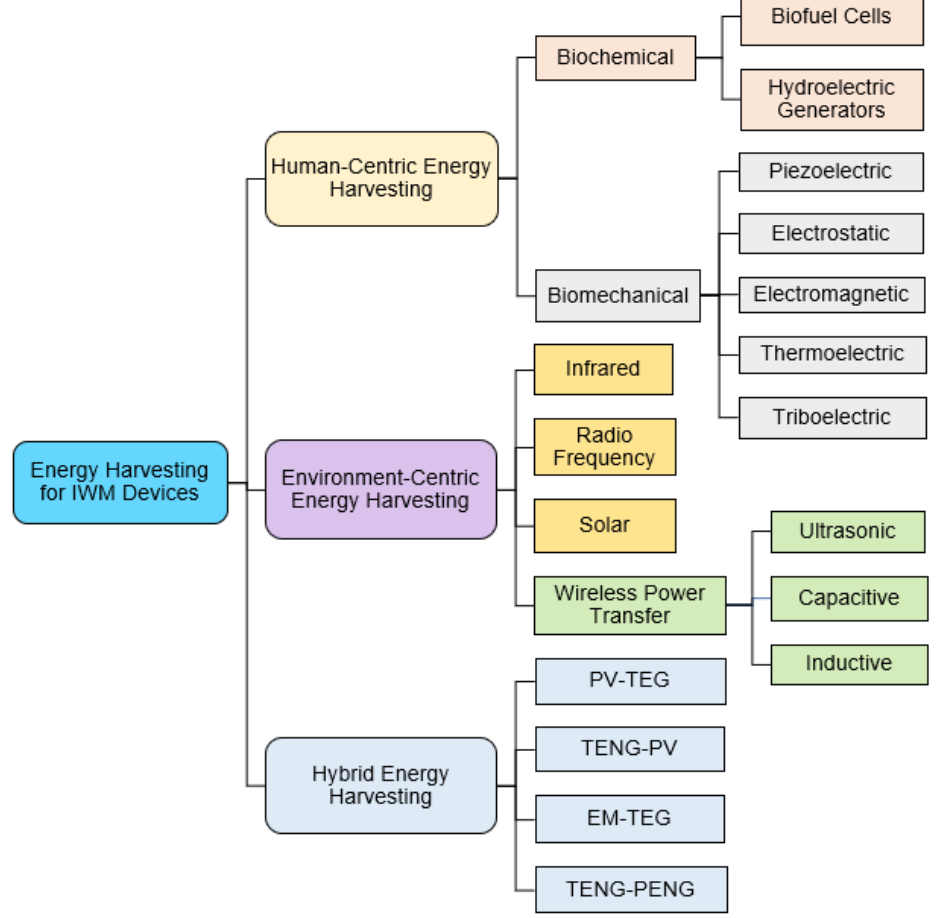
Figure 2. Classification of human- and environment-centric energy harvesting techniques exploited in implantable and wearable medical